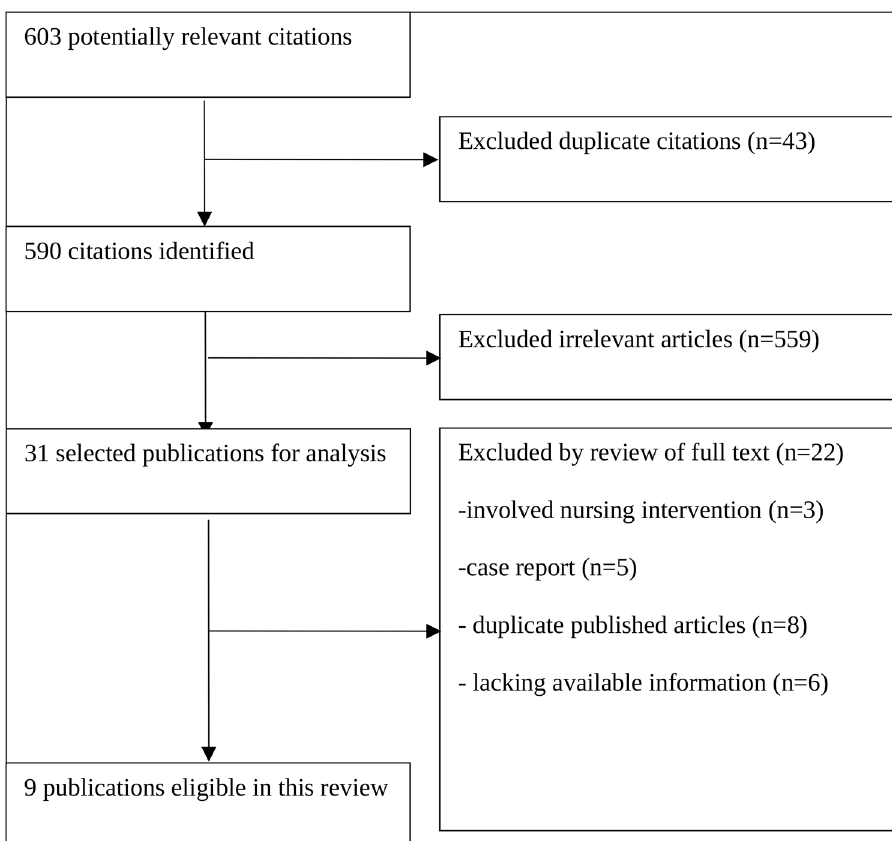
Fig 1. Flowchart of the Selection Process for Studies Included in the Systematic Review.